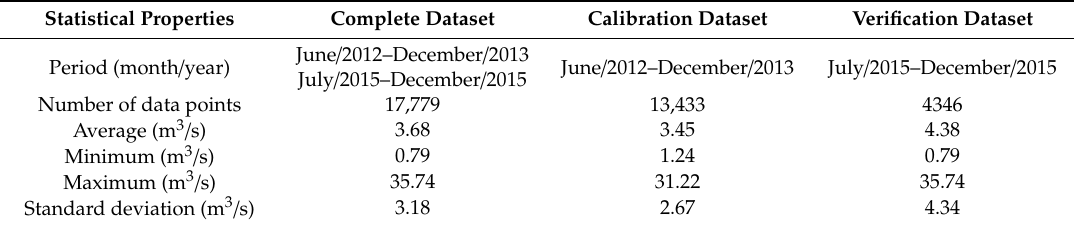
Table 4. Statistical summary of the runo ff data at Puente Viejo Station for the Jiboa River